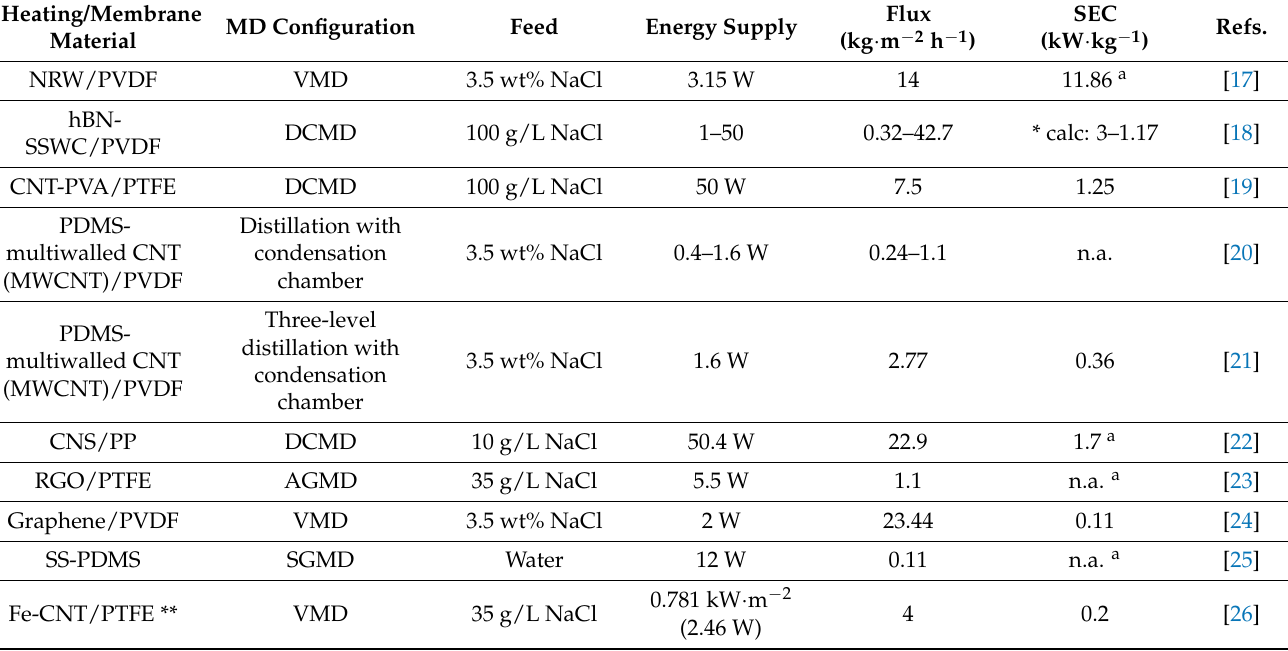
Table 1. Electrical heating on modified membranes (best